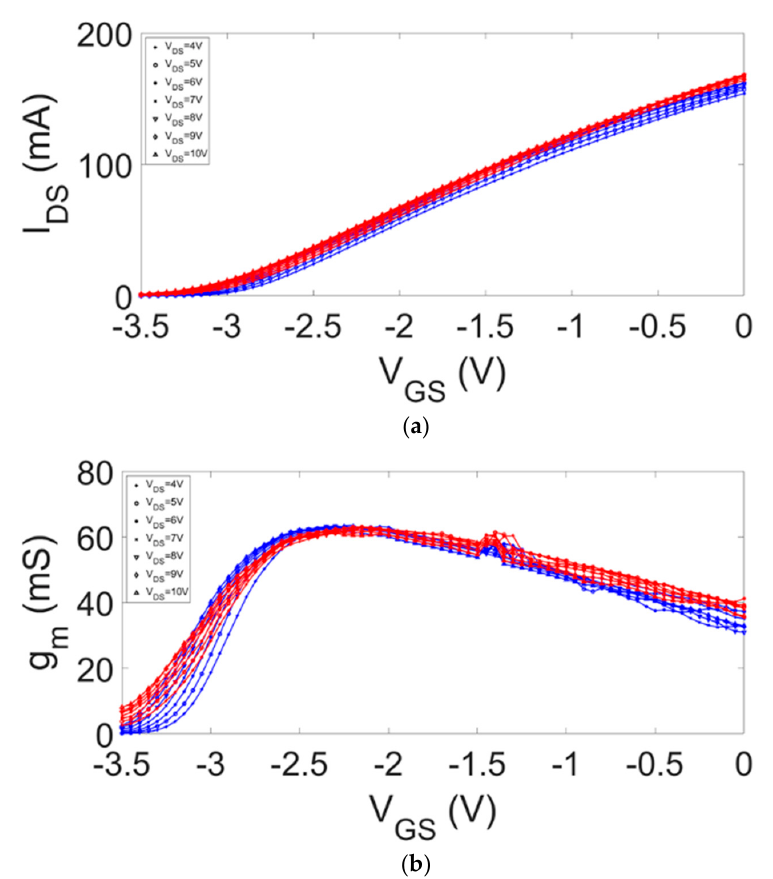
Figure 7. ( a ) I DS and ( b ) g m versus V GS with V DS from 4 V to 10 V (step 1 V) measured for the 200 µm HEMT without (blue line) and with (red line) laser exposure.